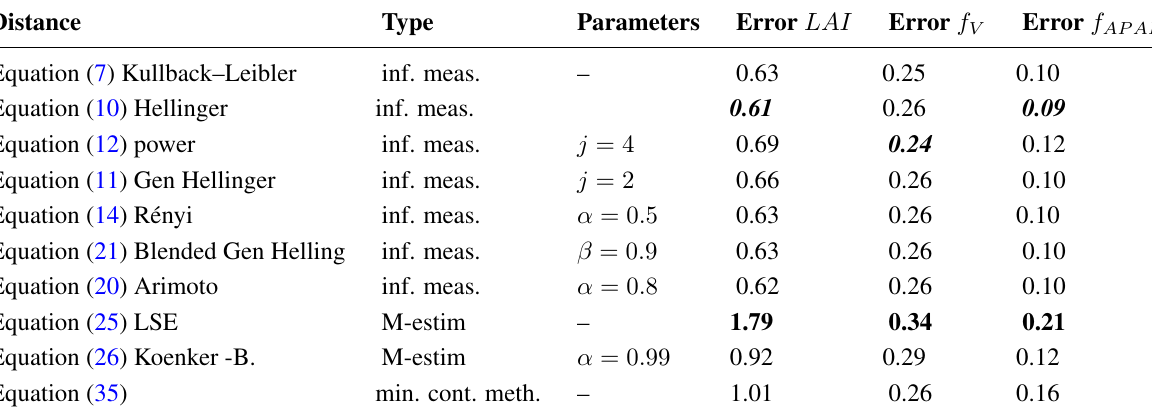
Table 4. Summary statistics for the performance of different distance measures in estimating biophysical parameters from ground reflectance data (BRF); reflectances were simulated for broadleaf trees.